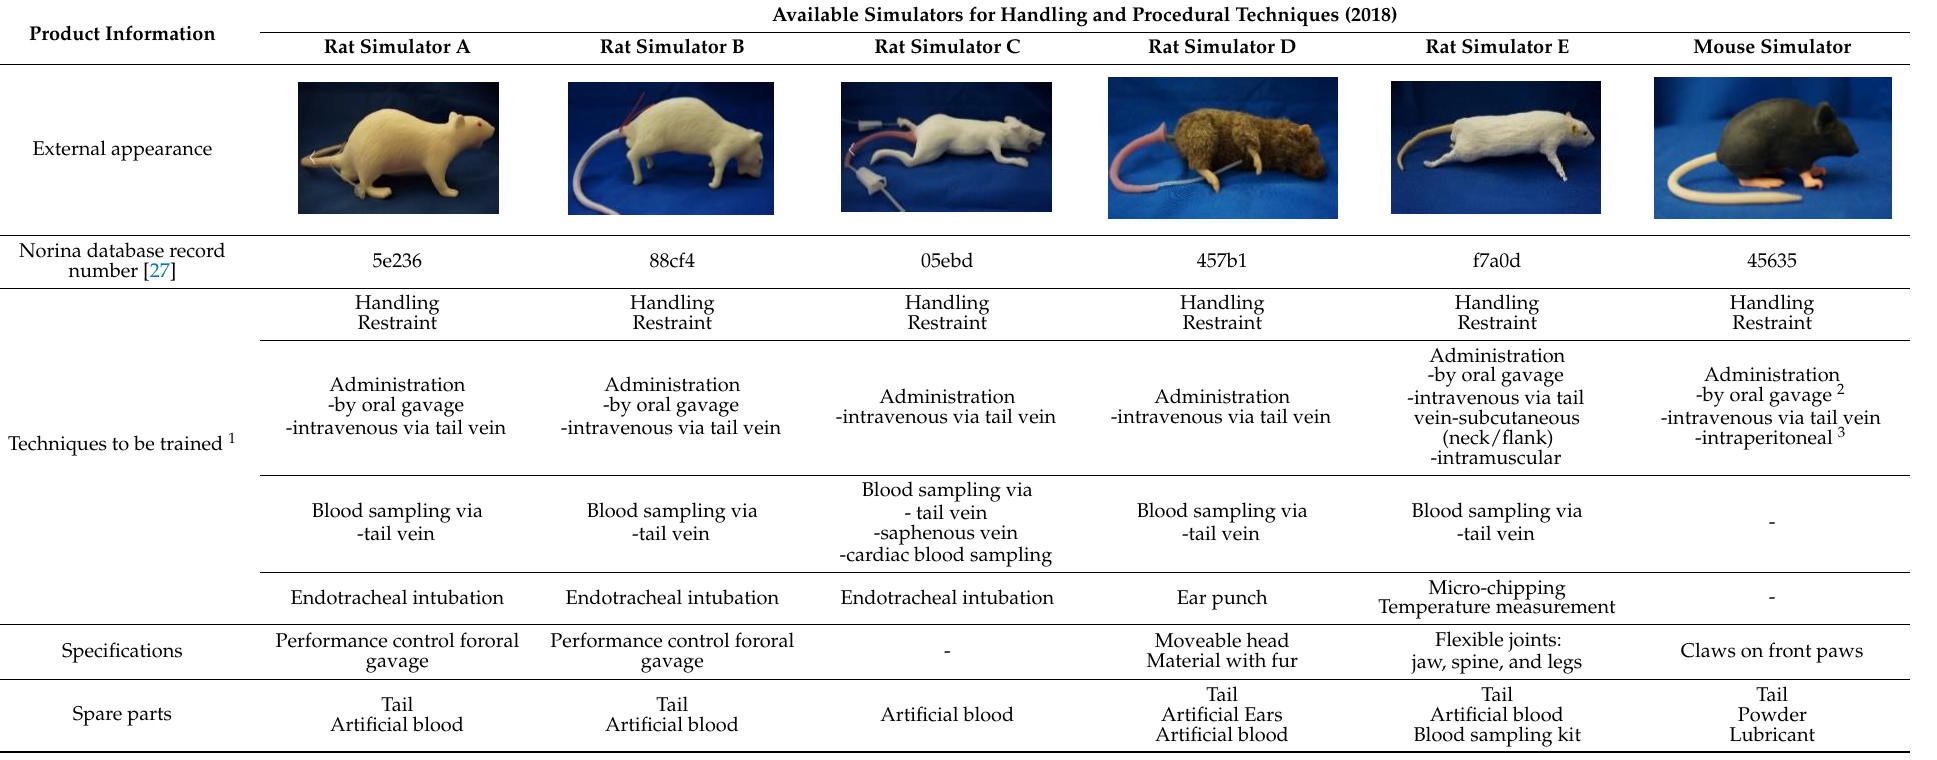
Table 1. Overview of available rat and mouse simulators for handling and procedural techniques, and for microsurgical techniques (2018). Product names were anonymized. Product Information